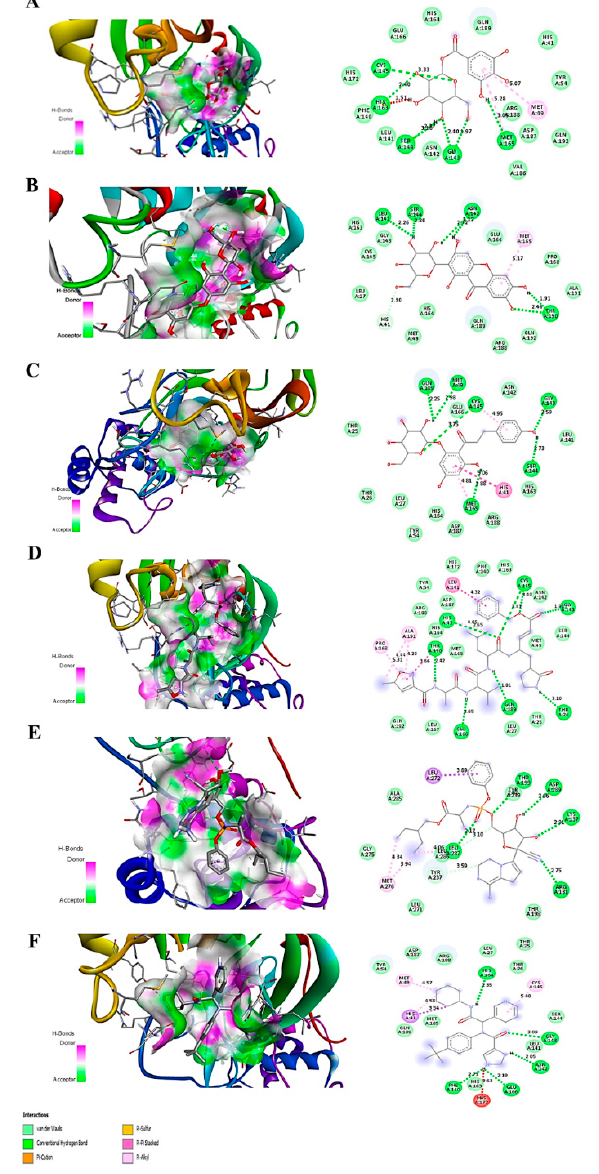
Figure 2. Predicted 3D structure of the ligand-protein interaction at the left side and 2D animated pose showing interaction. ( A ) Main proteases protein of SARS-CoV-2 with glucogallin. ( B ) Main proteases protein of SARS-CoV-2 with mangiferin. ( C ) Main proteases protein of SARS-CoV-2 with phlorizin. ( D ) Main proteases protein of SARS-CoV-2 with N3. ( E ) Main proteases protein of SARS-CoV-2 with remdesivir. ( F ) Main proteases protein of SARS-CoV-2 with X77.